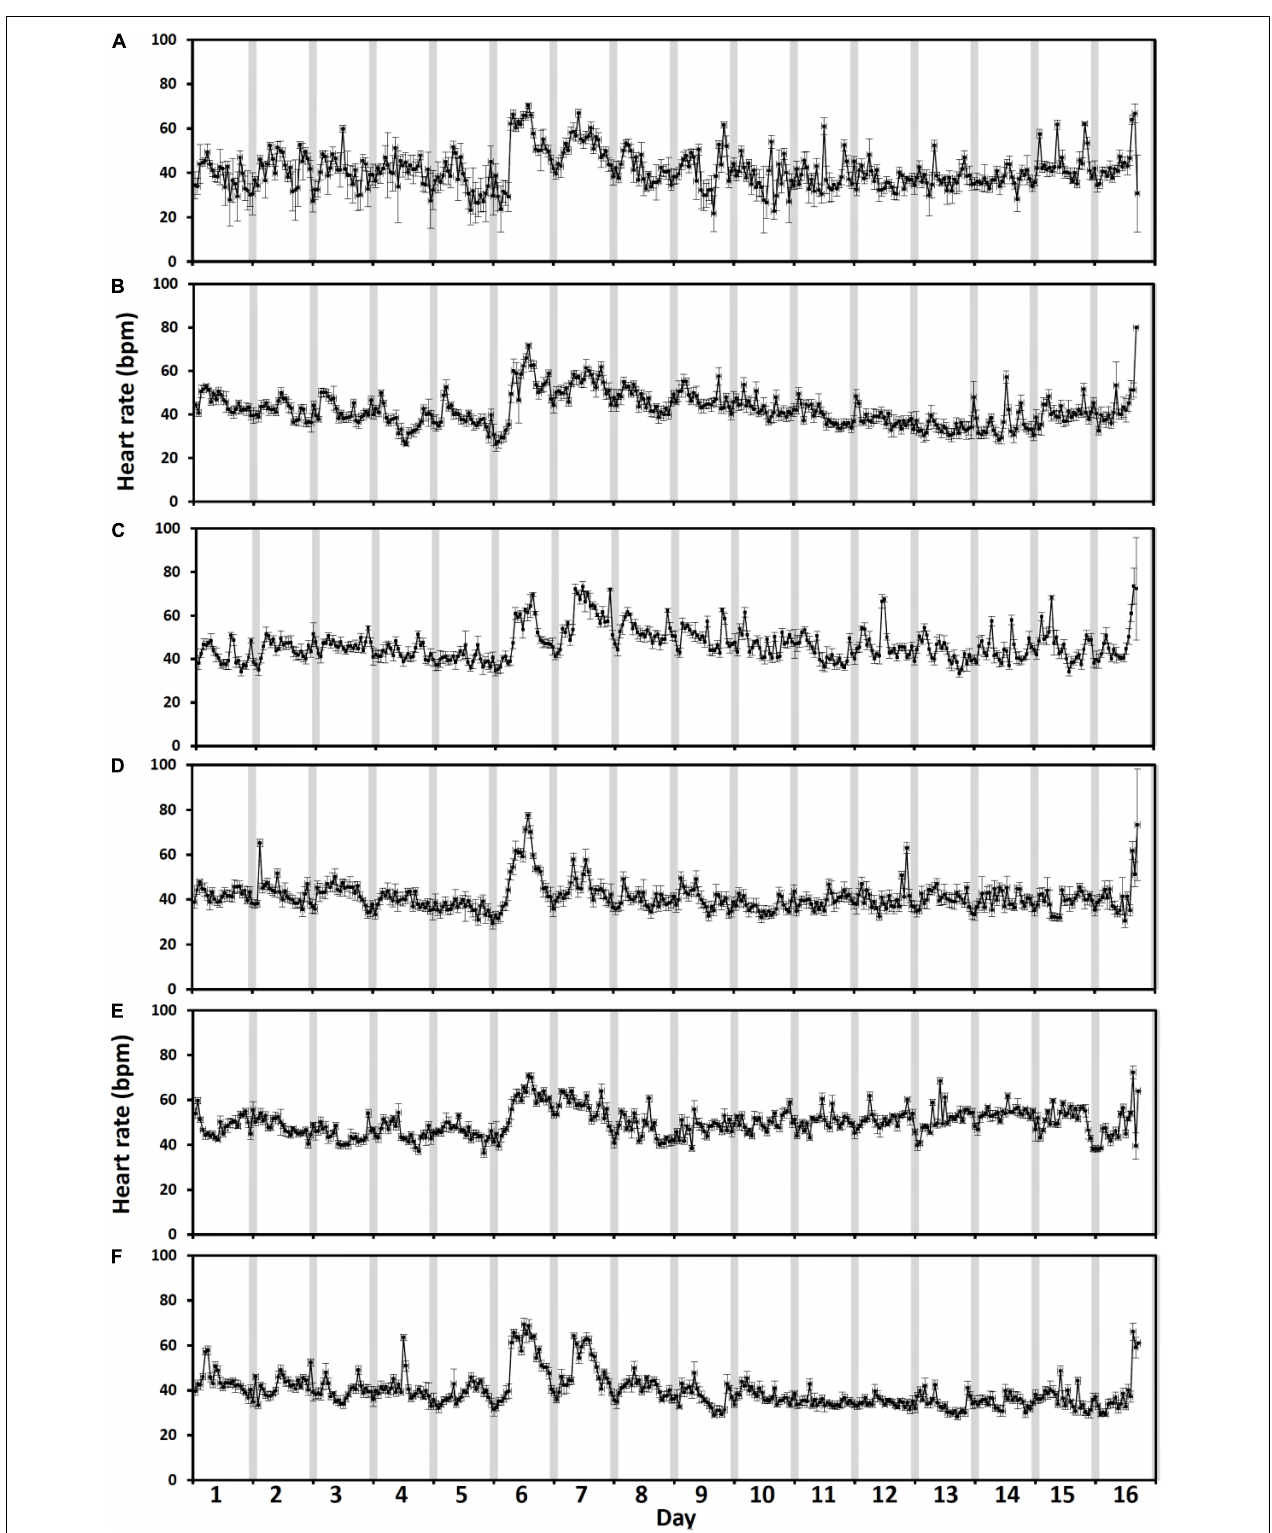
FIGURE 5 | (A–F) Individual fish response to an intensive sample event. Individual hourly heart rate in beats per minute (bpm) of the six six salmon (Fish C, D, H, M, N and P from Table 1 ) collected at harvest. Heart rate is shown from the 5 days prior to final cage sampling (days 1–5, the 17th to the 21st of June), fish sampling from the cage (day 6, the 22nd of June and post-sampling till harvest (days 7–16, the 23rd of June to the 2nd of July). Error bars represent ± 95% CI. Gray bars indicate approximate hours of civil darkness.